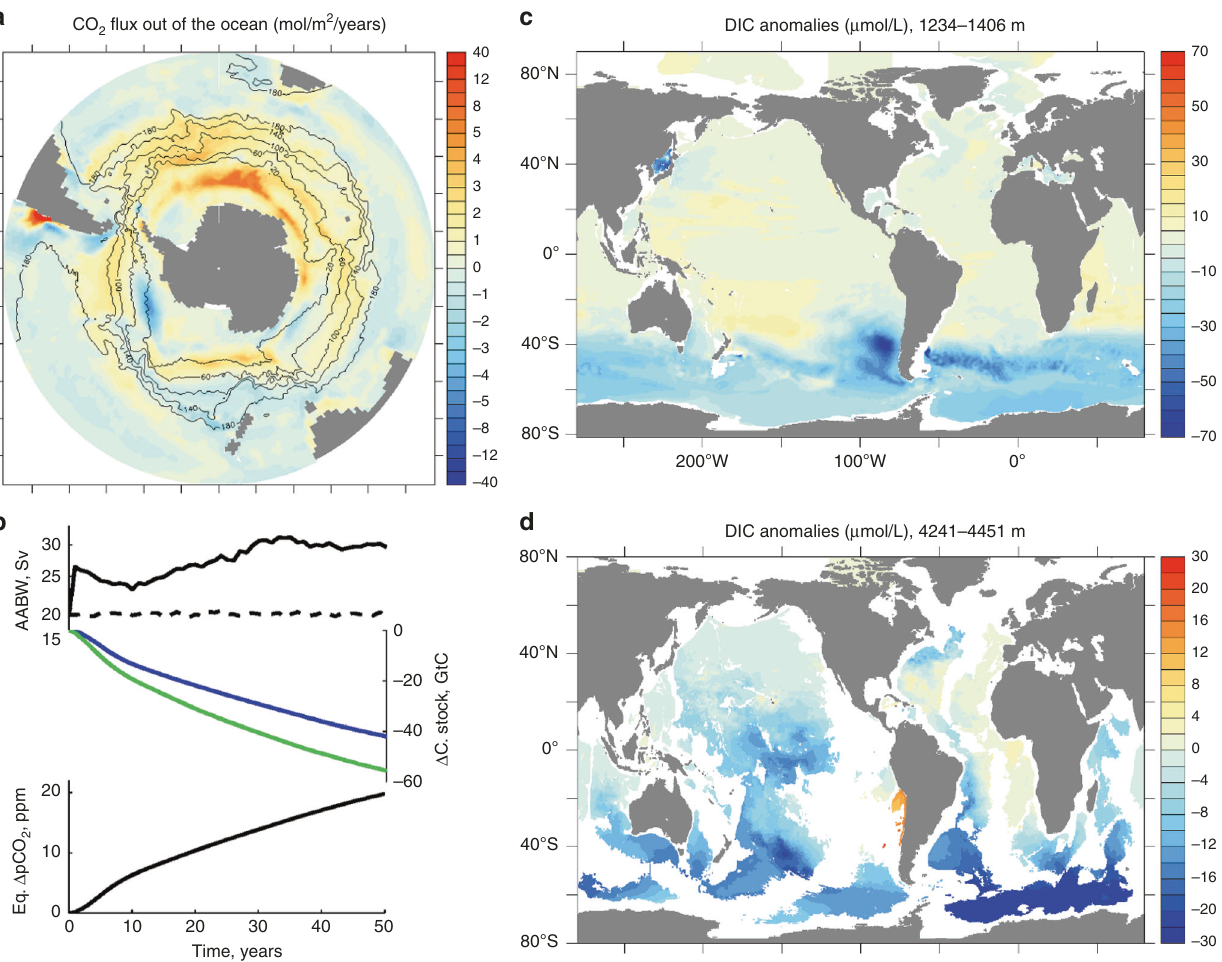
Fig. 6 Oceanic carbon response to poleward intensi fi ed SH westerlies as simulated by a global eddy-permitting model. a Δ CO 2 fl ux out of the ocean (shading, mol m − 2 yr − 1 ) with Antarctic Circumpolar Current stream lines (Sv) overlaid for the poleward intensi fi ed SH westerlies case. b Timeseries of maximum AABW transport in the perturbed (solid) and control (dashed) experiments, total (blue) and south of 36°S (green) ocean carbon change and p CO Δ C μ mol L − 1 ) at water depths c 1234 – 1406 m and d 4241 – 4451 m. Anomalies are at year 50 compared to 2 equivalent ( oc /2.12); DIC anomalies (